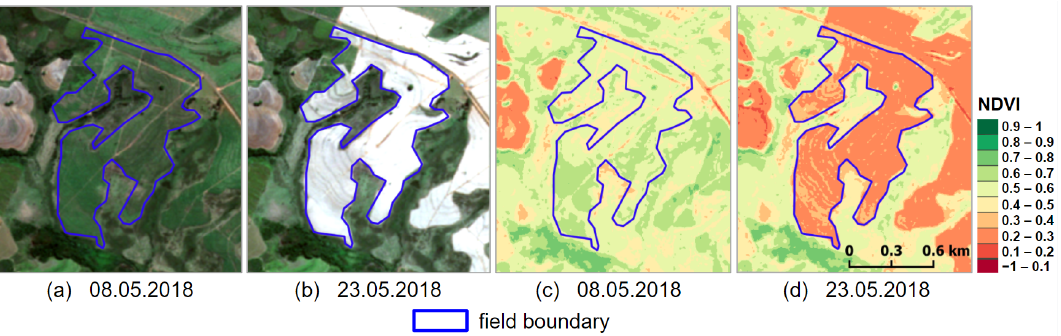
Figure 4. Example of a sugarcane parcel before ( a , c ) and after harvest ( b , d ) in natural colours ( a , b ) and NDVI ( c , d ).